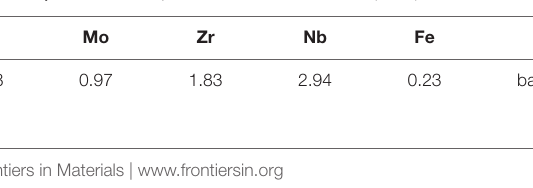
TABLE 2 | Chemical composition of sintered material